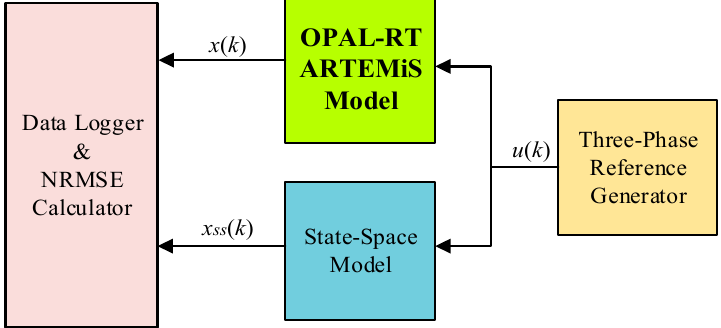
Figure 5 . Proposed validation of the integrated state-space model of the inverter-based generator. Figure 5. Proposed validation of the integrated state-space model of the inverter-based